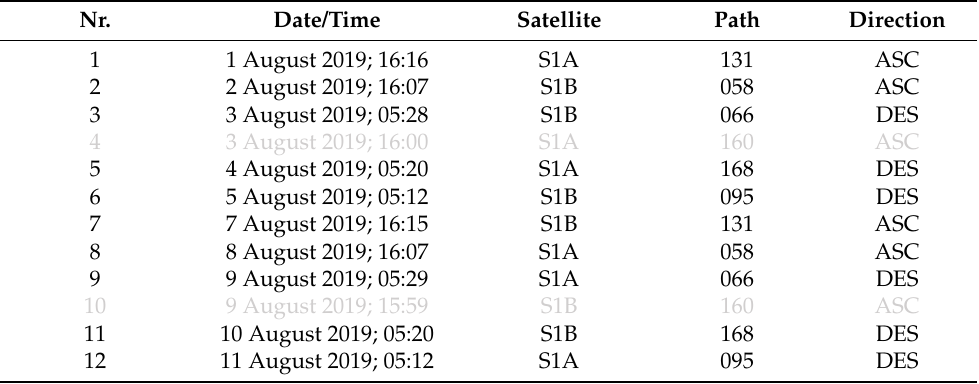
Table 1. S1 paths over the Hansjordnesbukta tidal gauge station in Tromsø during a 12 day S1 cycle period 1–12 August 2019. Paths in gray were eliminated due to the cutoff incidence angle at 33.8 ◦ . Nr. Date/Time Satellite Path